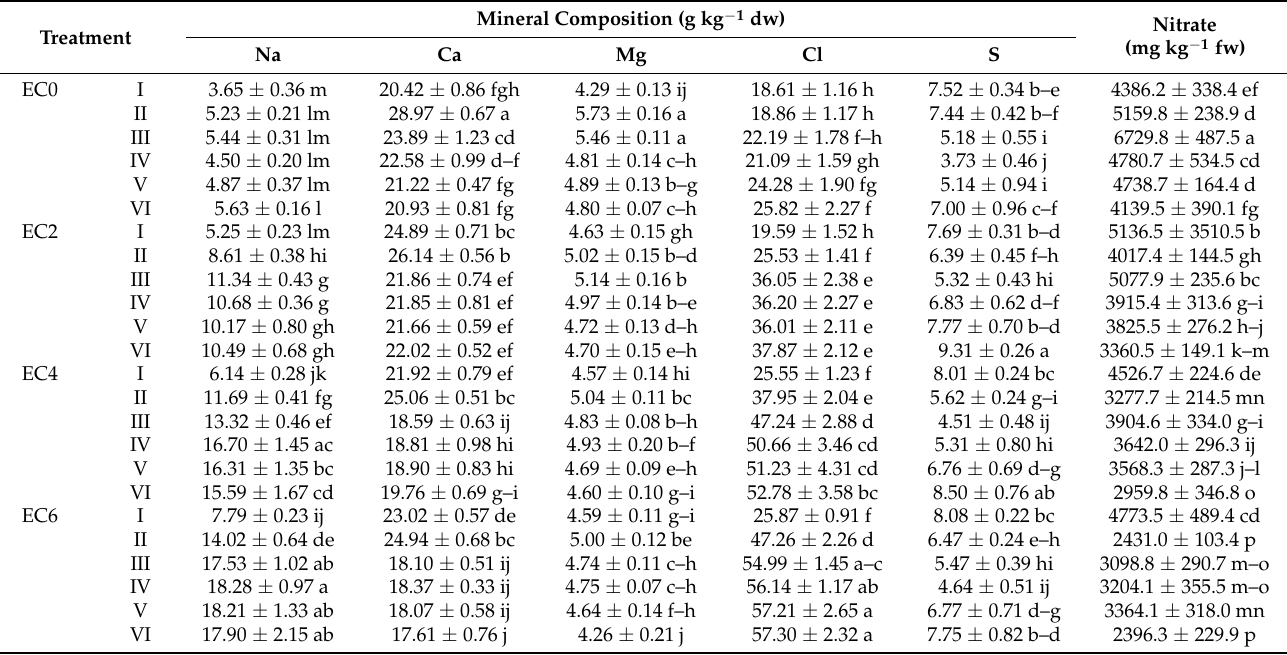
Table 6. Effect of salinity and harvesting time on minerals (Na, Ca, Mg, Cl, and S) and nitrate content in Diplotaxis tenuifolia leaves, regardless of biostimulant